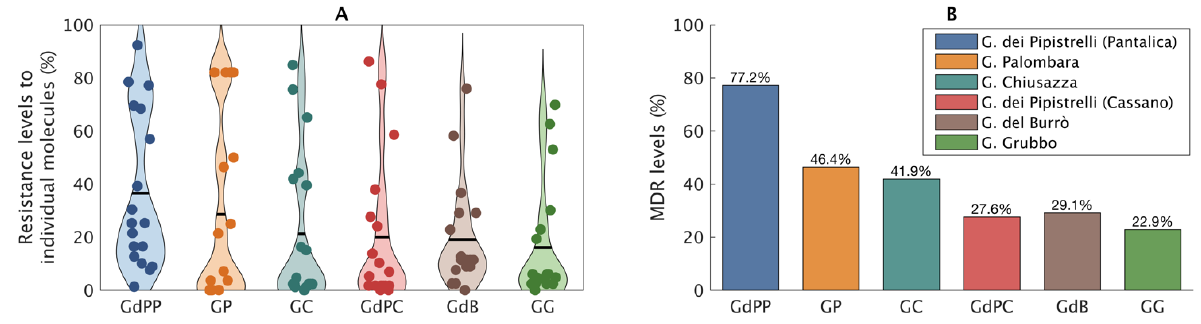
Figure 3. ( A ) Resistance levels to individual molecules and ( B ) percentage of multi-drug resistant (MDR) strains at different sites. Figure legend: GdPP = Grotta dei Pipistrelli (Pantalica), GP = Grotta Palombara, GC = Grotta Chiusazza, GdPC = Grotta dei Pipistrelli (Cassano), GdB = Grotta del Burrò, GG = Greve Grubbo.